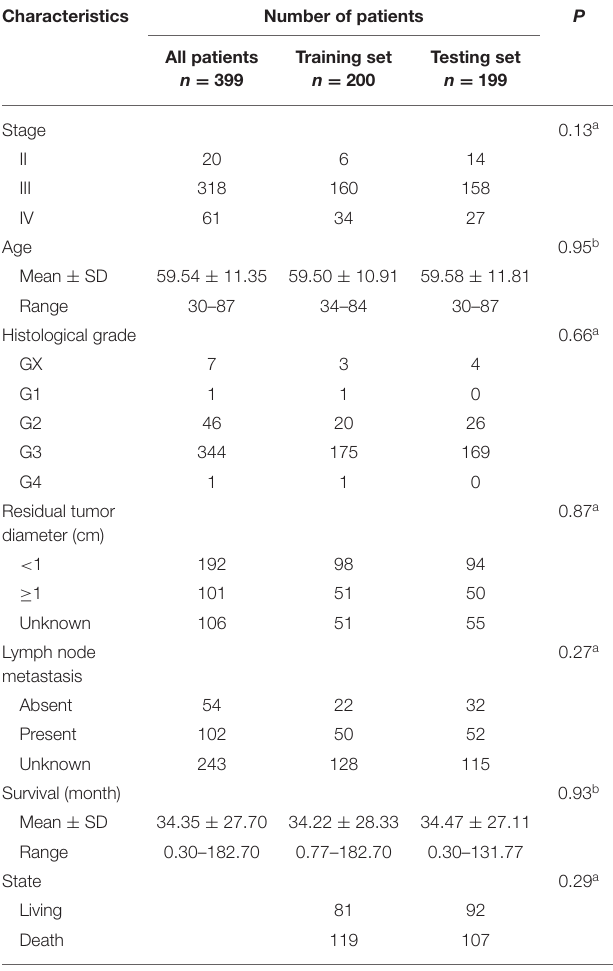
TABLE 1 | Clinicopathologic characteristics of ovarian cancer patients ( n = 399).